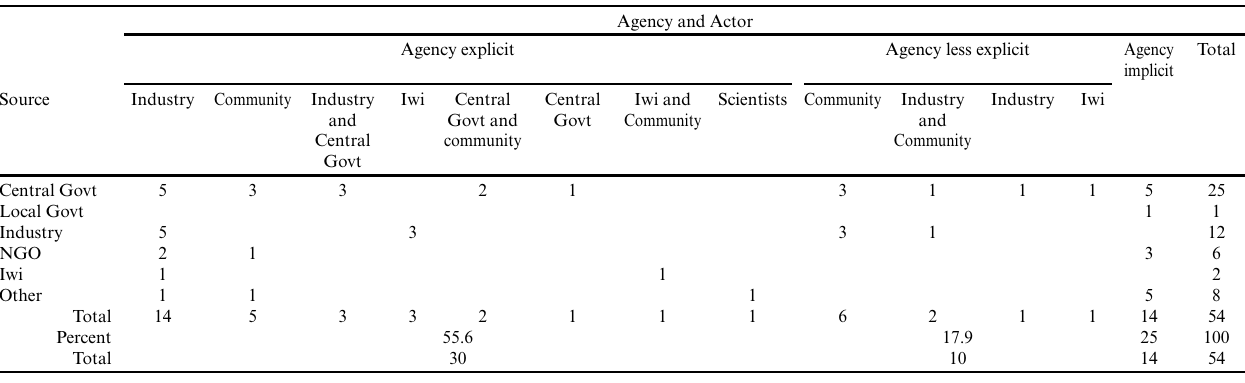
Agency and Actor Agency explicit Agency less explicit Agency Total implicit Iwi Central Central Iwi and Scientists Community Industry Industry Iwi and Govt and Govt Community and Central community Community Govt